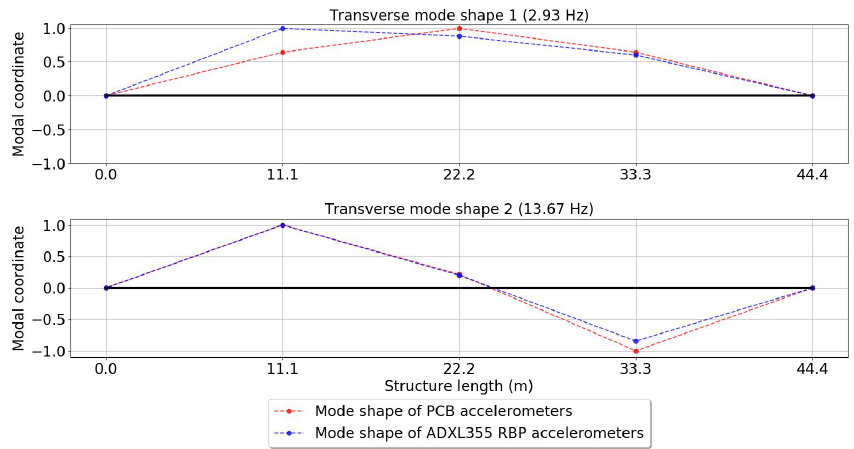
Figure 30. Transverse mode shapes of the railway bridge estimated by the monitoring systems. The modal identification carried out by the low-cost SHM system had a good estima- tion. As occurred in the flexible structure monitoring, the natural frequencies reported